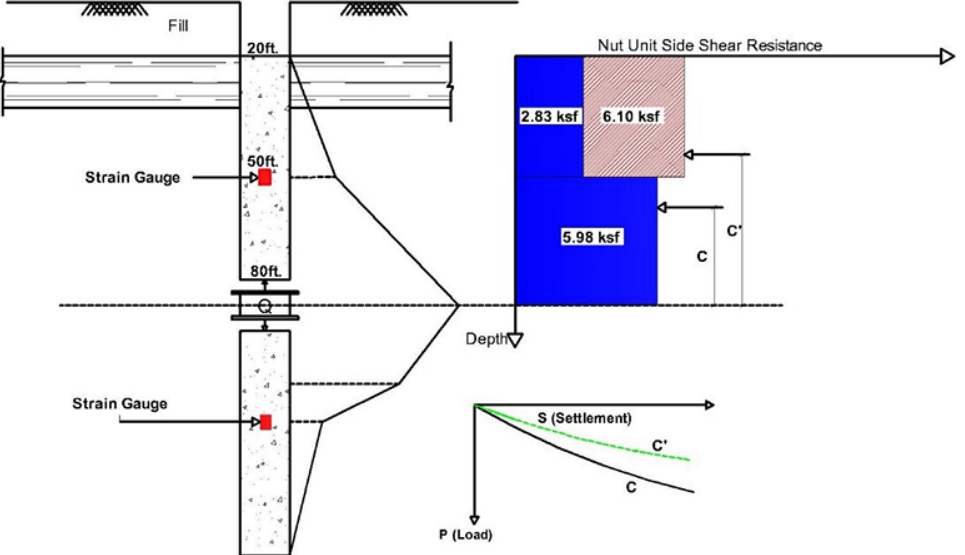
Figure 15. Unit Side Resistance and Load–settlement Comparison for O-cell test and Conventional Test (Case Study I).